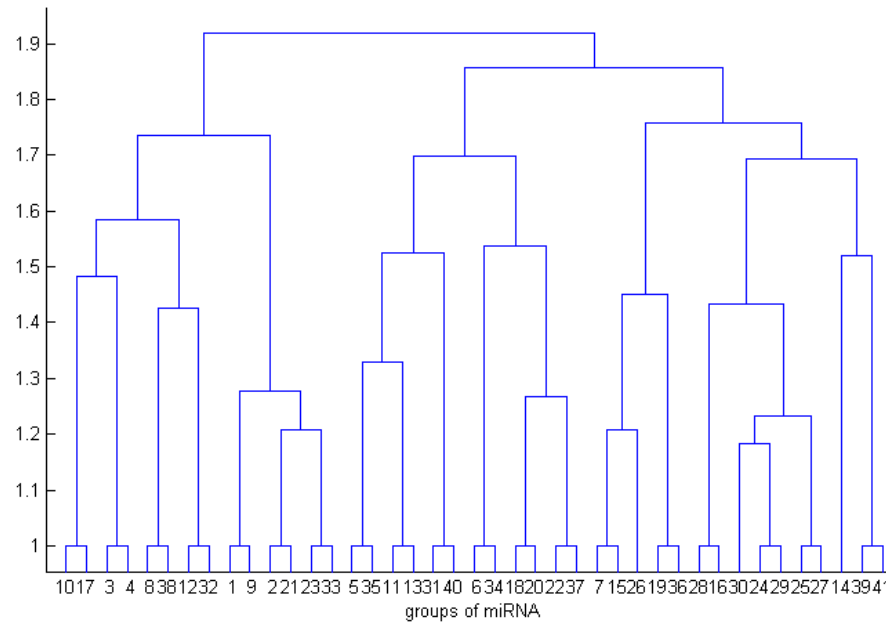
Figure 2. Ninety miRNA classifications subject to target cancer.